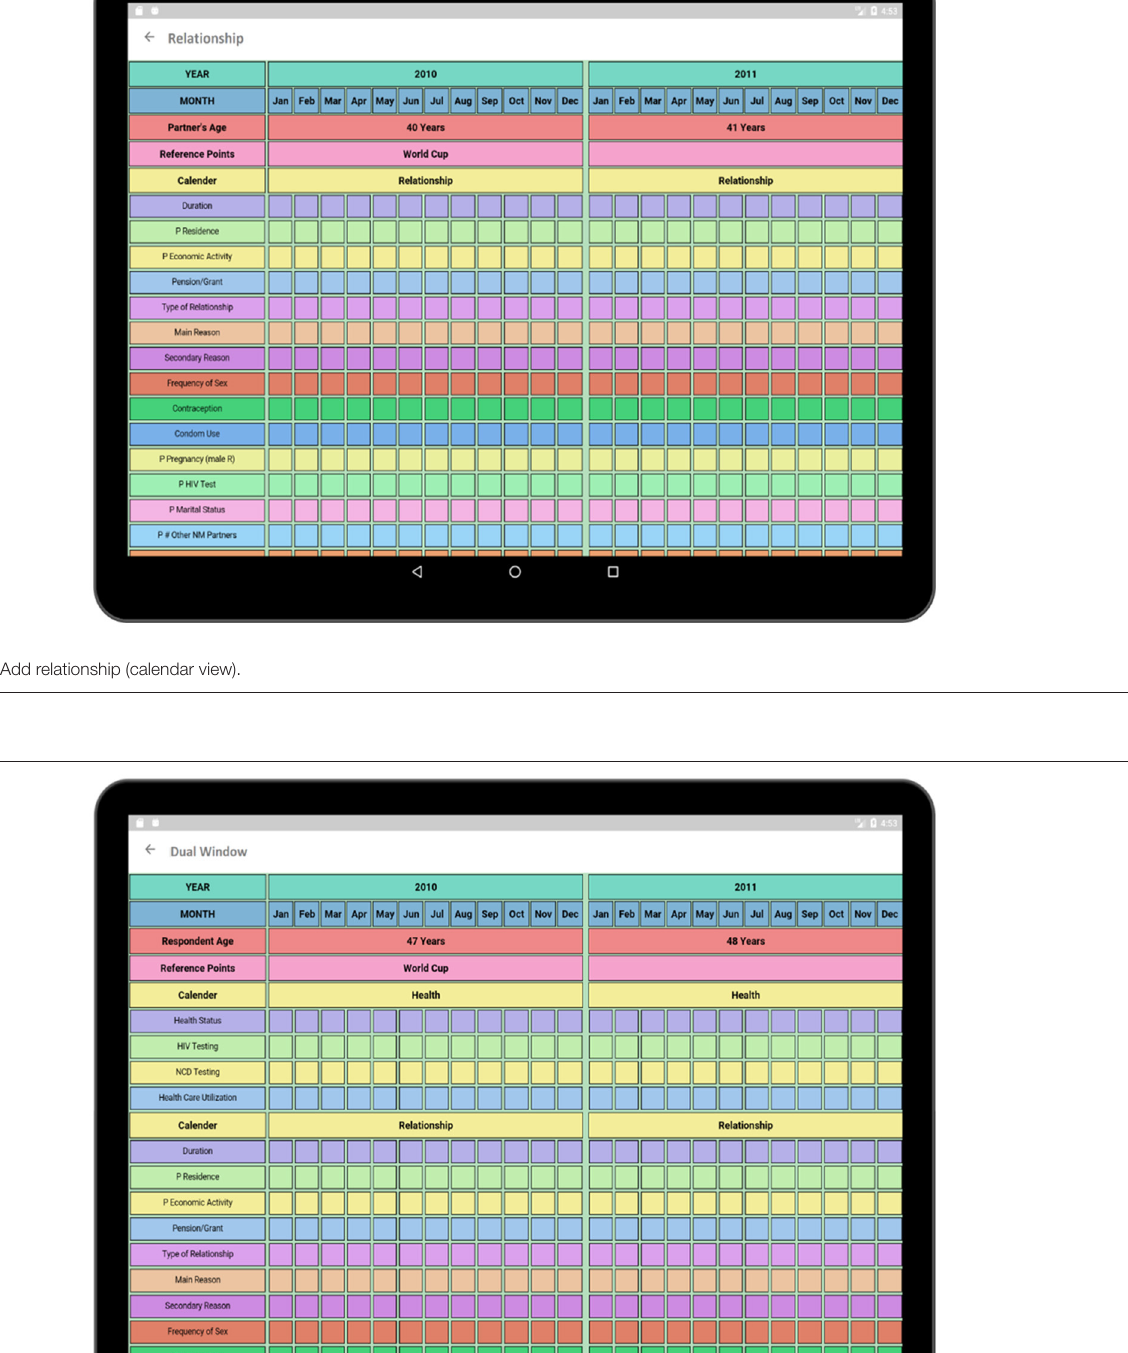
Frontiers in Reproductive Health |